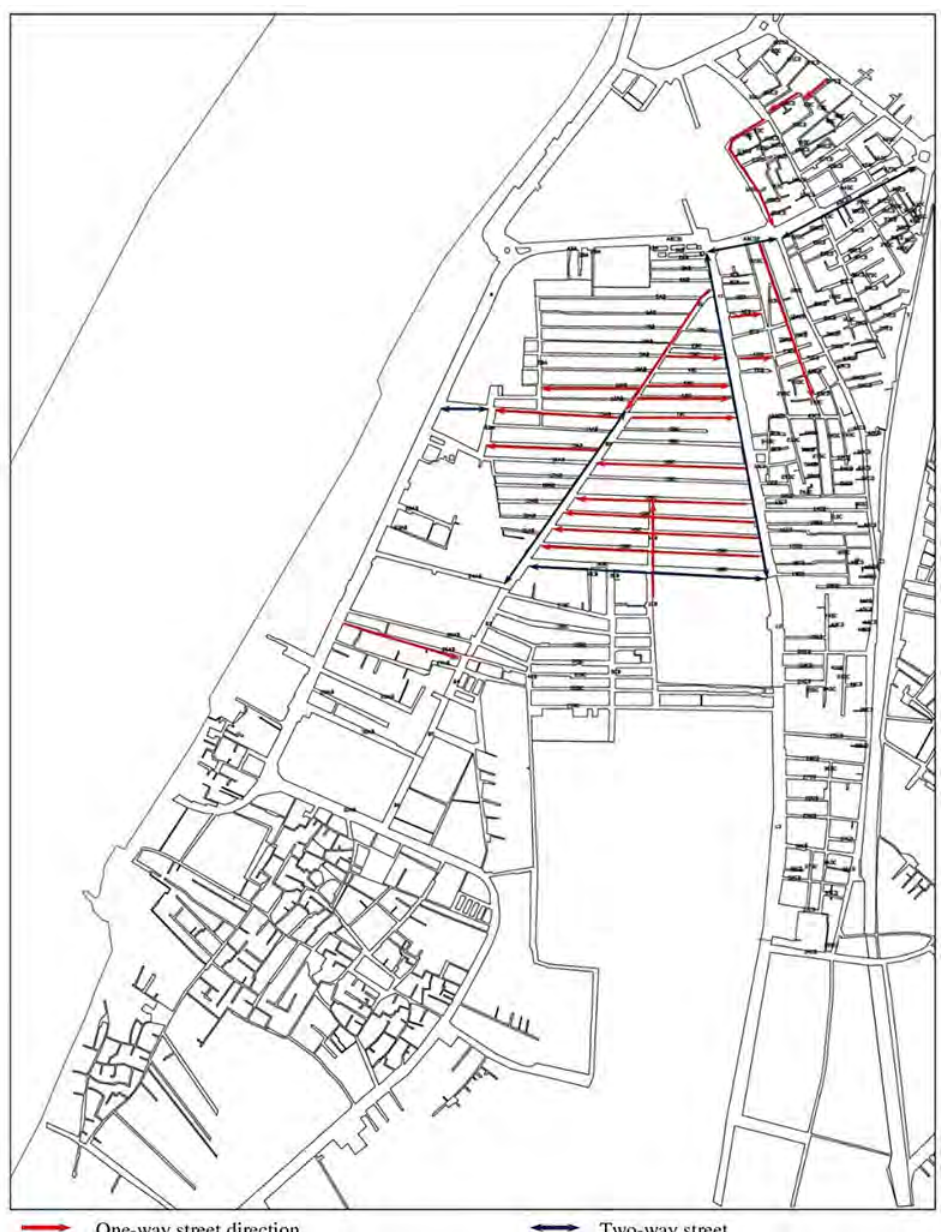
Figure 7. The designed